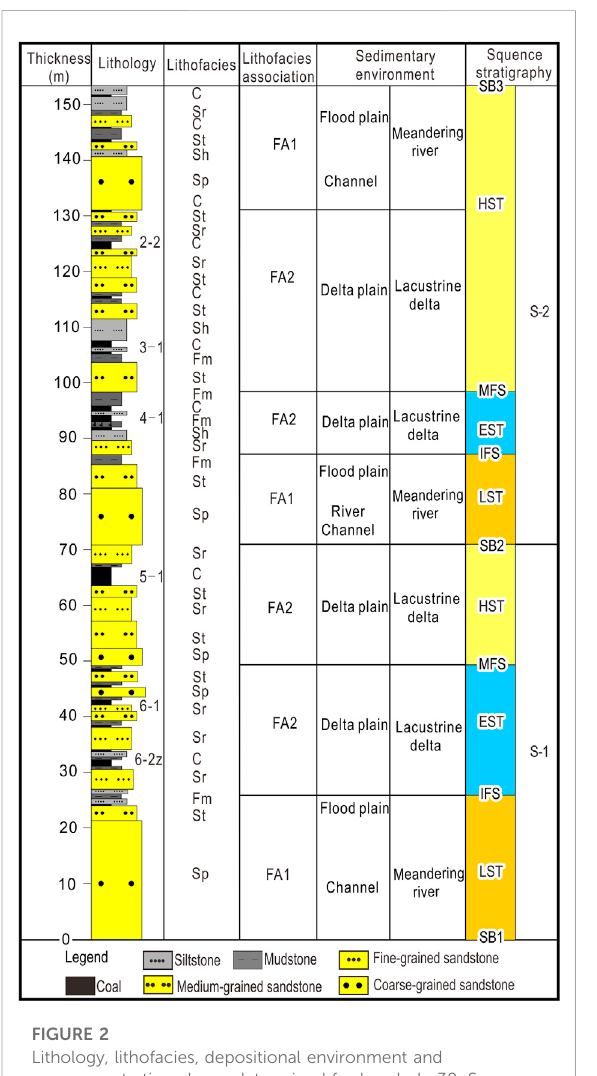
FIGURE 3 Lithology, lithofacies, depositional environment and sequence stratigraphy as determined for borehole 243. See Figure 1B for well